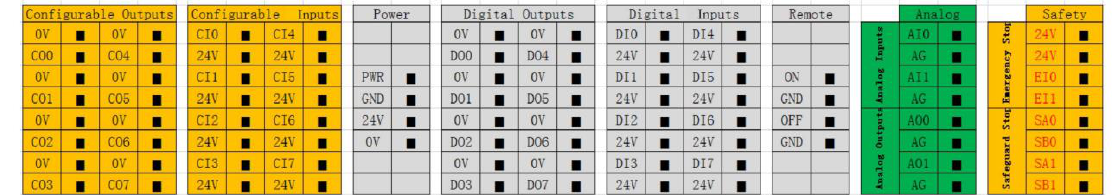
Figure 5. Electrical interface of Elfin 10 robot electrical box.